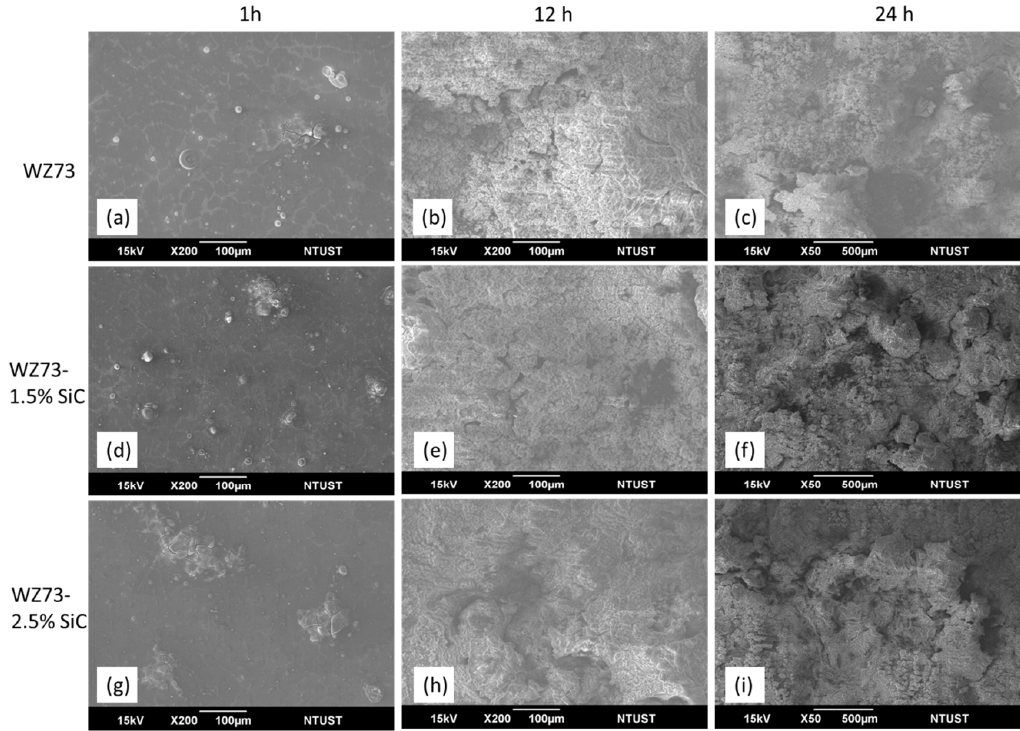
Figure 7. Surface morphology of WZ73 after immersing in 1 wt % NaCl solution for ( a ) 1; ( b ) 12 and ( c ) 24 h; WZ73-1.5 vol% SiC after ( d ) 1; ( e ) 12 and ( f ) 24 h; WZ73-2.5 vol% SiC after ( g ) 1; ( h ) 12 and ( i ) 24 h.